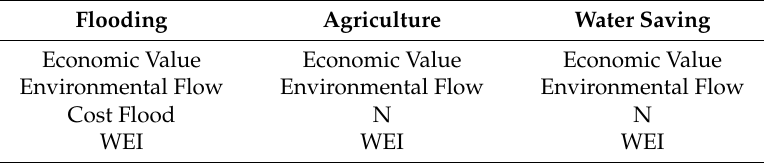
Table 3. Overview of the group of main criteria considered for optimization.